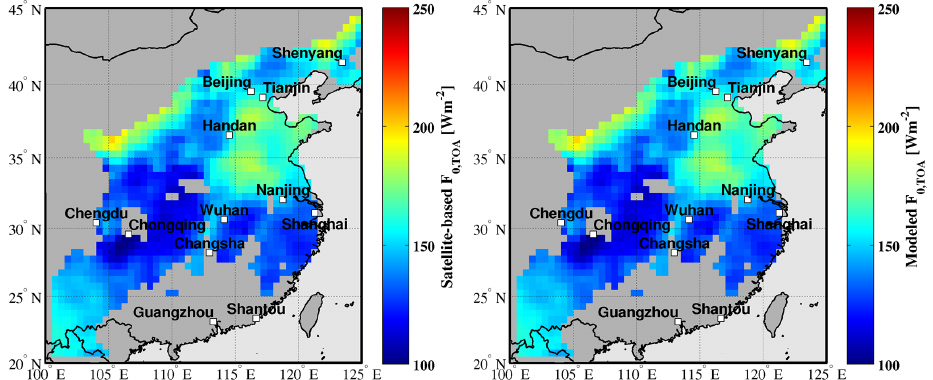
Figure 8. Geographical distribution of F 0 , TOA values, during March of 2009, according to (left) satellite-based method and (right) radiative transfer simulations.